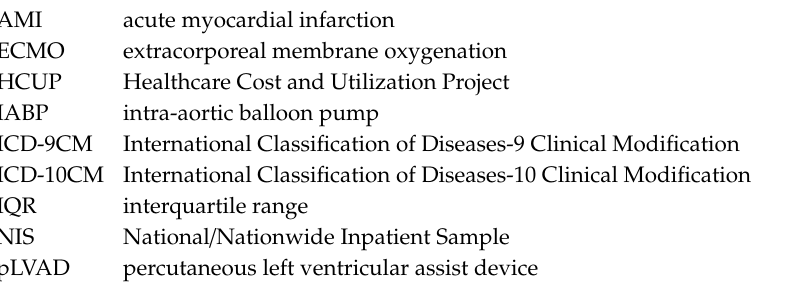
Table S1: Administrative codes, Table S2: Predictors of complications in AMI admissions receiving